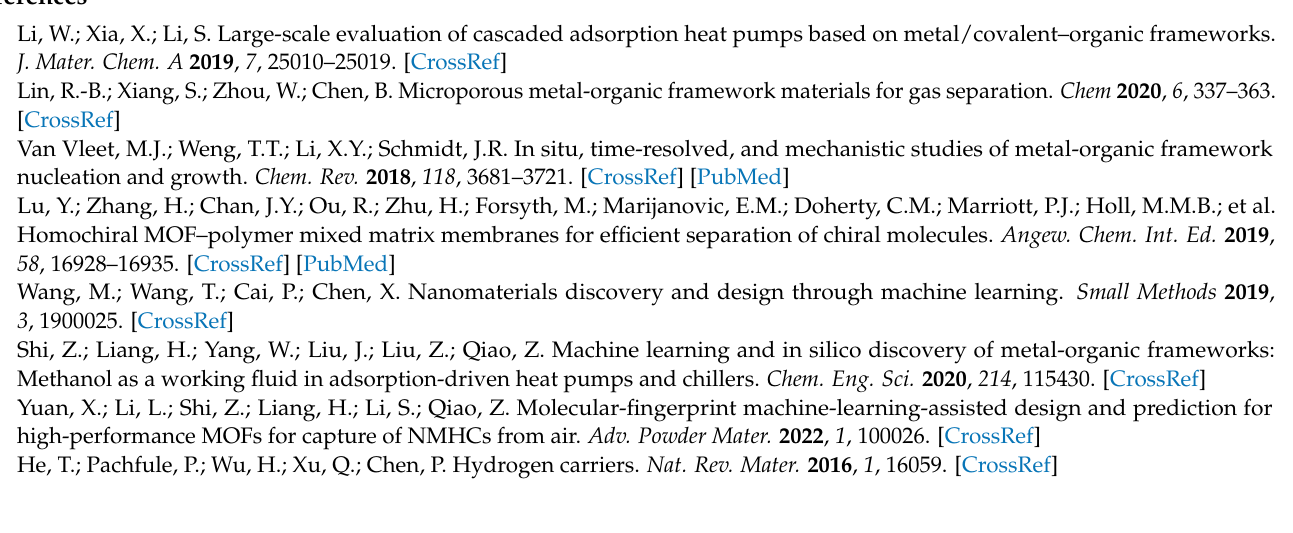
Figure S5: Diffusion coefficient D and Permeability P versus PLD for N 2 and O 2 in 6013 CORE- MOFs; Figure S6: Tree-based pipeline optimization tool; Figure S7: Decision tree; Figure S8: Random forest; Figure S9: k-fold cross validation; Table S1: Lennard–Jones parameters of MOFs; Table S2: Lennard–Jones parameters and charges of adsorbates; Table S3: Kinetic diameter of CH 4 , N 2 , O 2 and H 2 ; Table S4: The constraints for screening the best MOFs/MOFMs under each system; Table S5: Design Strategies of MOFs and MOFMs with high performance. References [48,63–66] are cited in the supplementary